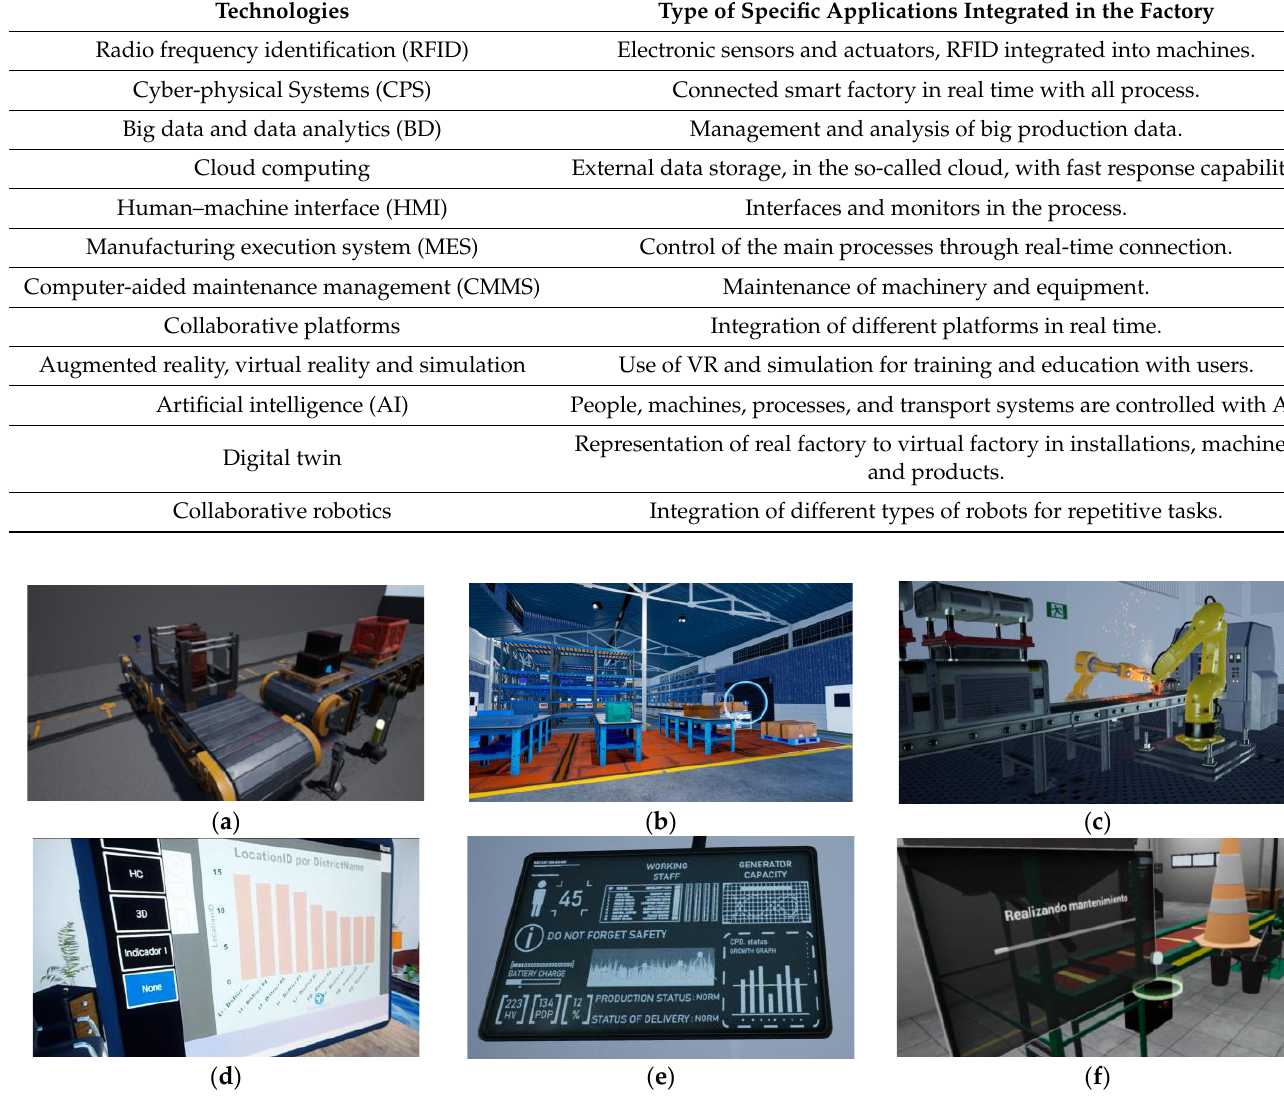
Figure 6. Some Industry 4.0 technologies’ implementation in the smart factory case study: ( a ) sensors, actuators, and radio frequency identification (RFID) in conveyors; ( b ) realistic representation of a storage system using digital twin; ( c ) autonomous robots collaboratively working on repetitive tasks; ( d ) big data and data analytics in real time in the process; ( e ) human–machine interface with interfaces and